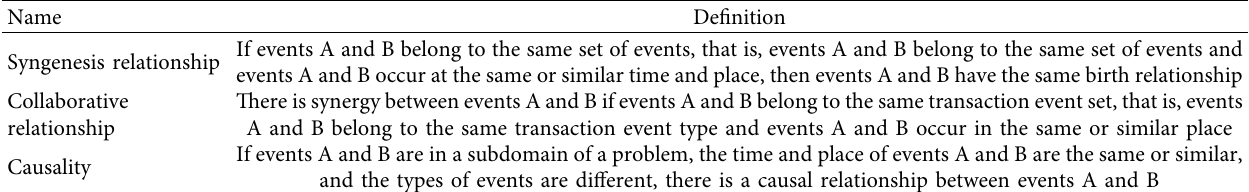
Table 2: Complex relations of events.